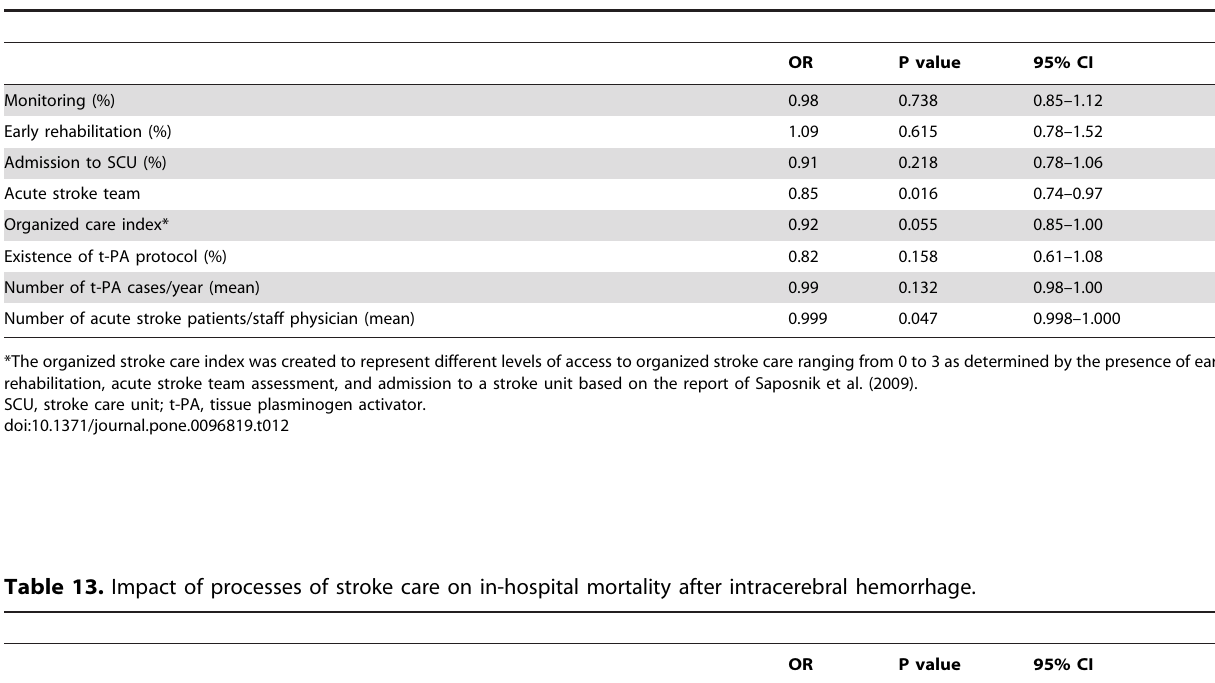
Table 12. Impact of processes of stroke care on in-hospital mortality after ischemic stroke.